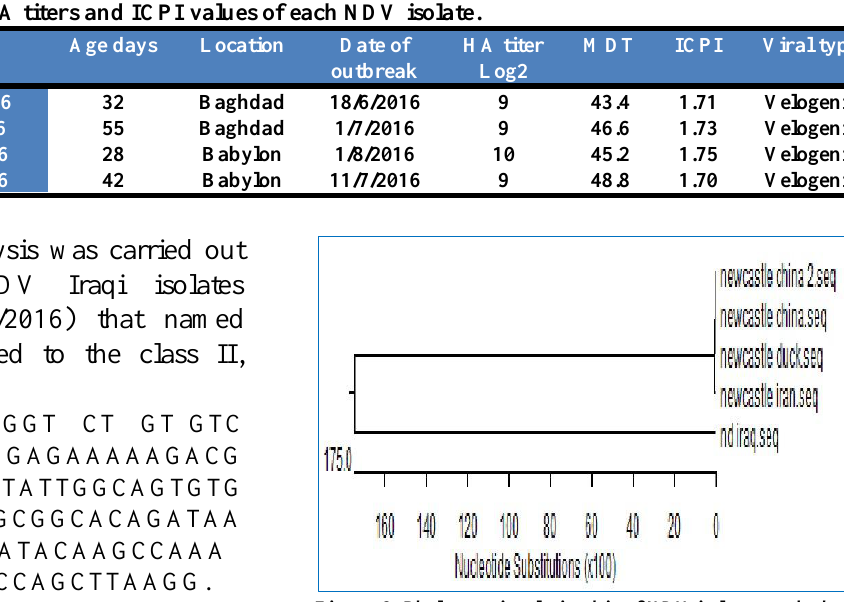
Figure, 2: Phylogenetic relationship of NDV isolates on the basis F gene nucleotide sequencing between position 158 and 513. The phylogenetic tree was assembled by joining method on MEGA.